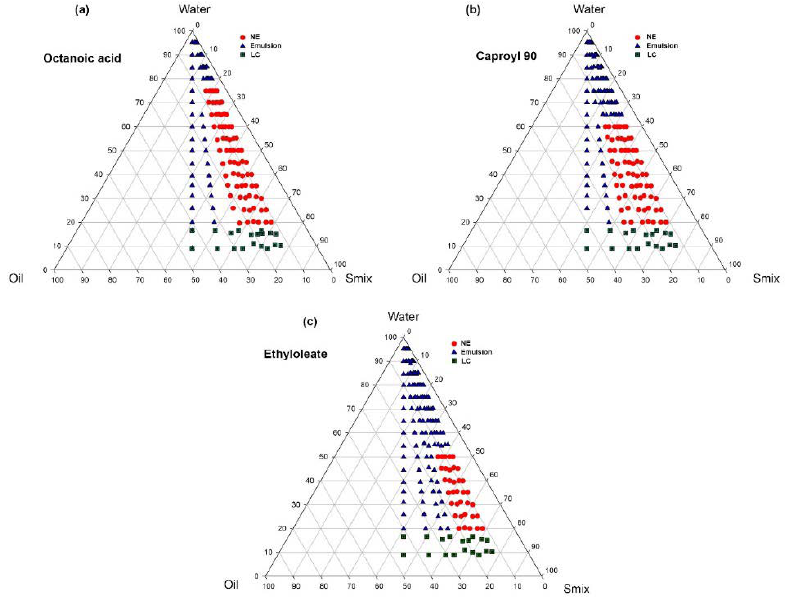
Figure 2. Phase behavior study by constructing pseudoternary phase diagrams for oil phase consist- ing of ( a ) octanoic acid as oil phase at Smix ratio 1:1, ( b ) capryol 90 as oil phase at Smix ratio 1:1, and ( c ) ethyl oleate as oil phase at Smix ratio